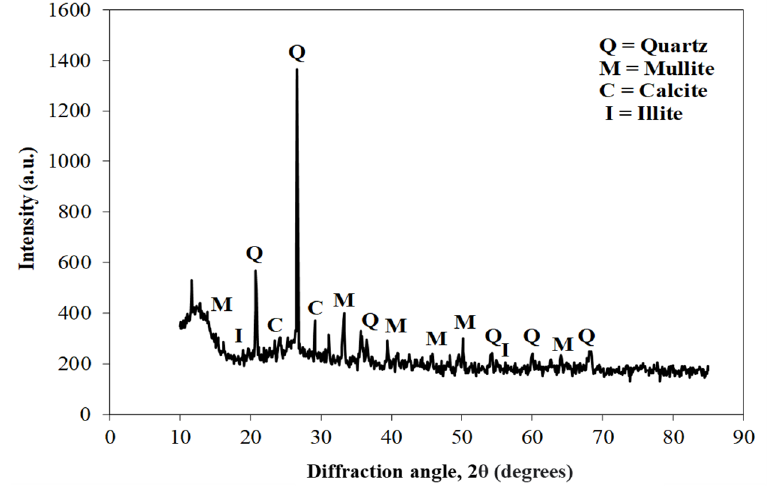
Figure 6. XRD of coal ash.